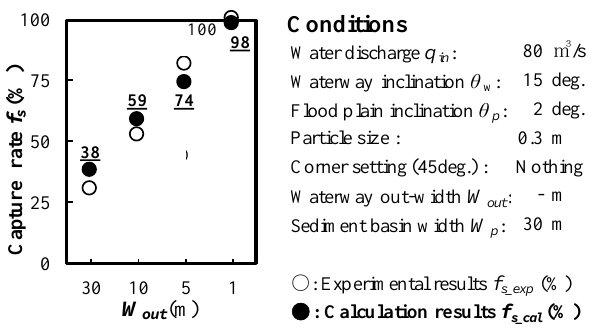
Figure 22. Comparison of the experimental results and numerical analysis results for changes in the downstream opening width of the sediment retarding basin.